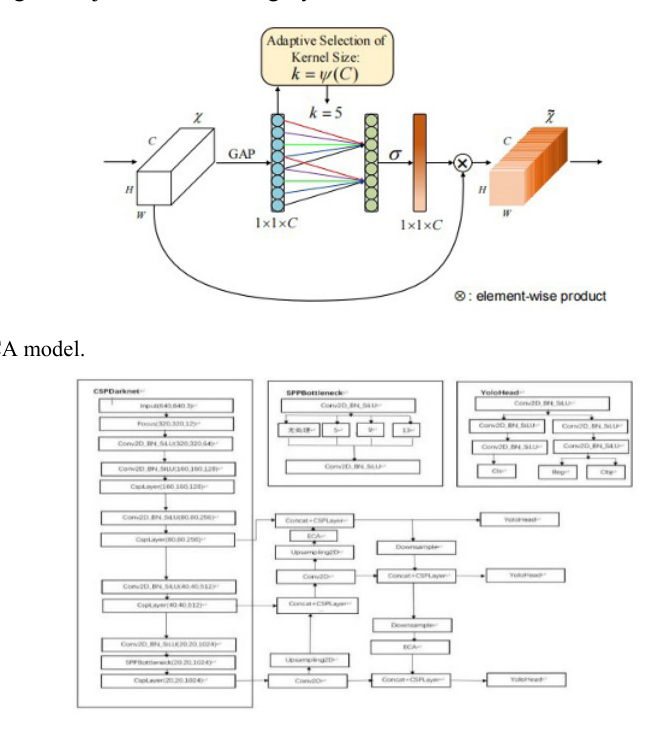
Fig. 2. The YOLOX model architecture added to the ECA